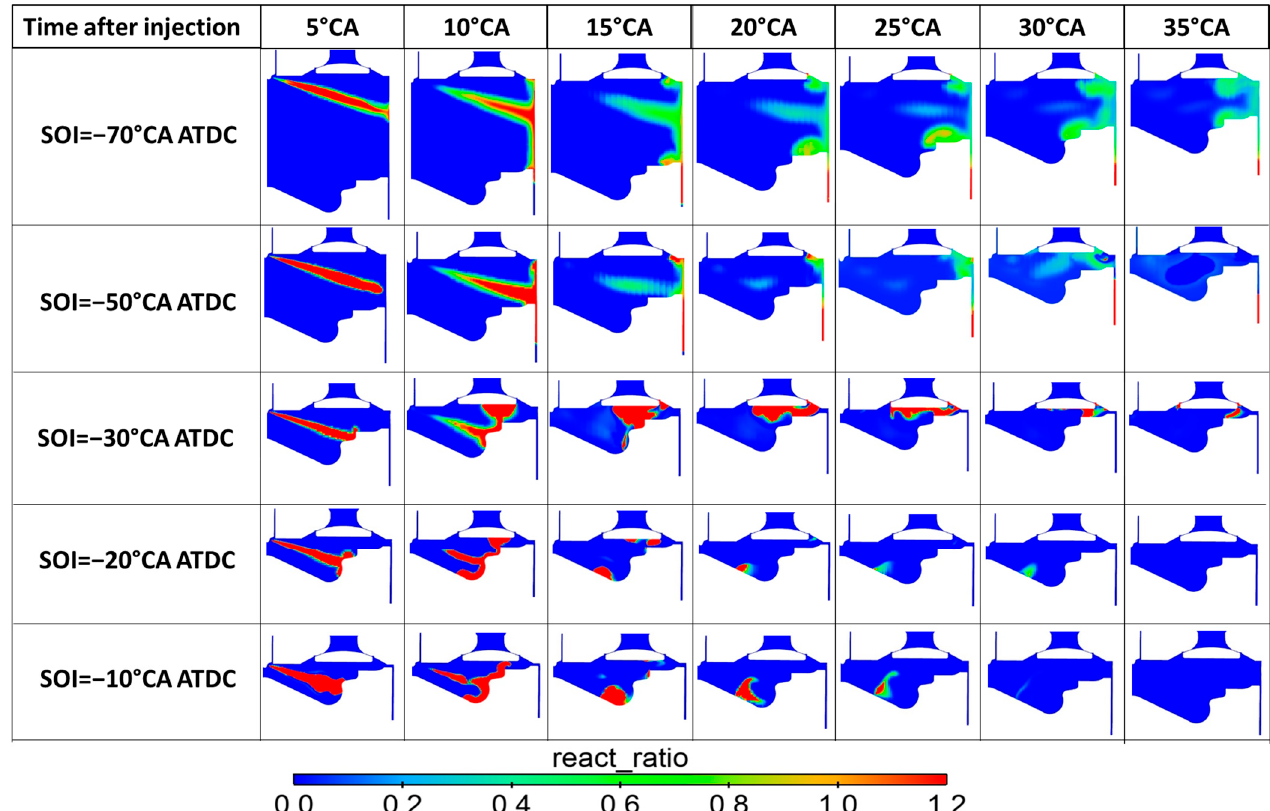
Figure 19. Time histories of RER contour plot in a plane formed by the cylinder axis and a spray axis according to °CA after SOI for various SOI timings.